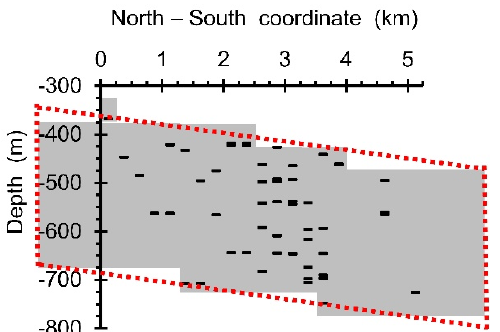
Figure 2. Illustration of the basic 2D model: envelope around all mined longwall panels (indicated by short black lines), including an extension of 1 km to north and to south, with a lower water pressure. The red dotted line follows the average dip of the strata. The gray shaded area is the discretization of the envelope, taking the dimensions of each element into account, i.e., a height of 50 m and a north–south length of 250 m.